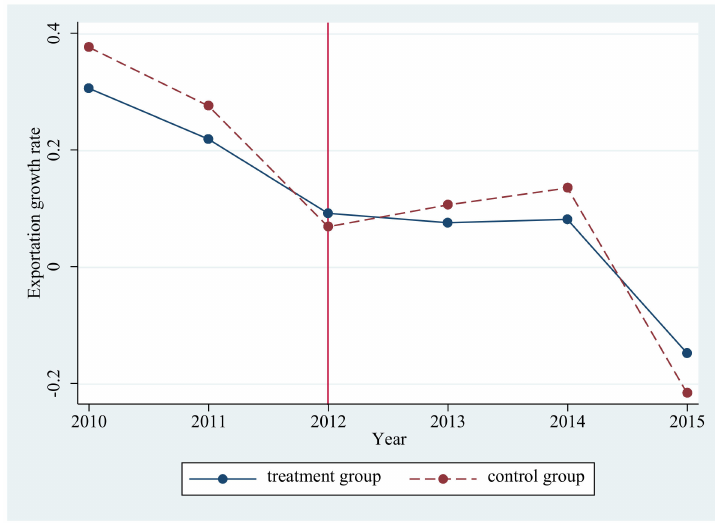
Figure 2. Exportation growth rate between the treatment and control groups.